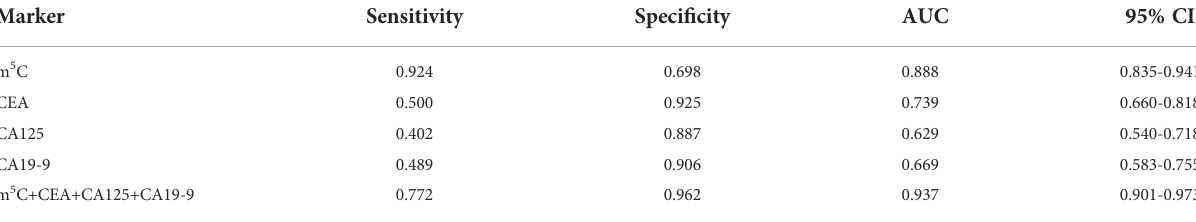
TABLE 2 Sensitivity and speci fi city of the diagnostic value of tumor biomarkers in the training set. Marker